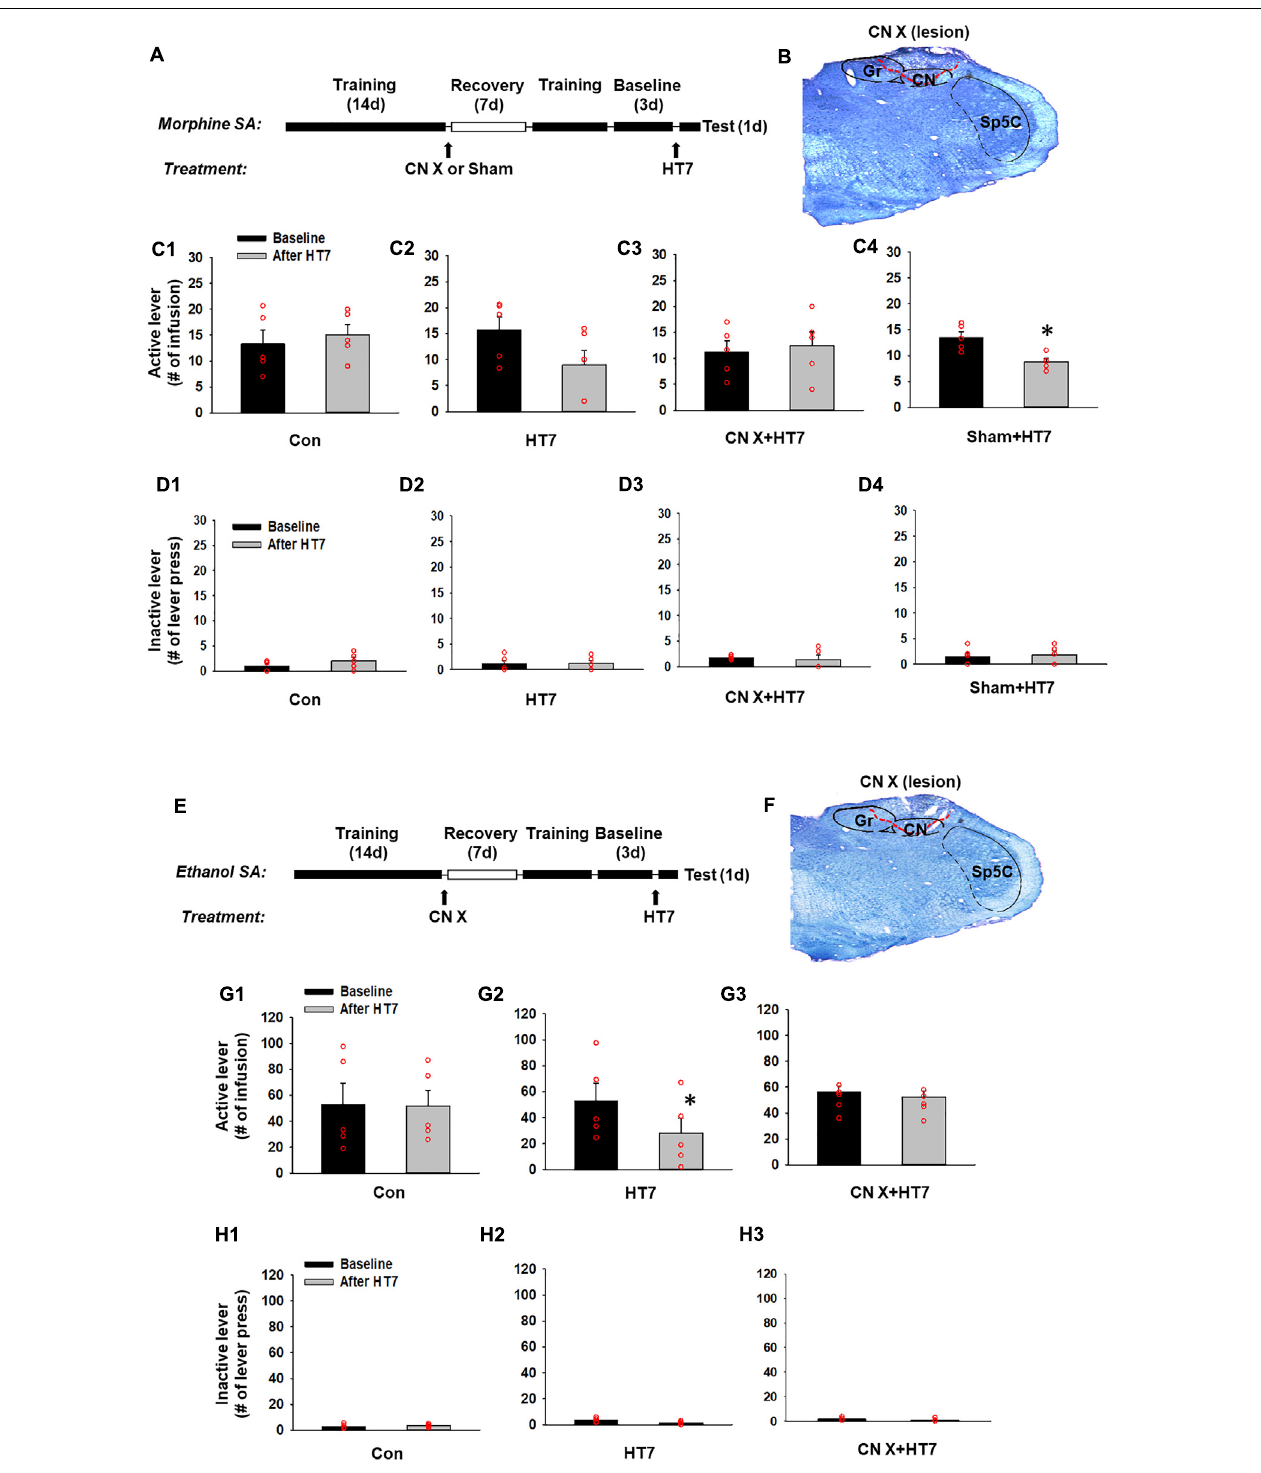
FIGURE 2 | Effect of cuneate nucleus (CN) lesions on the inhibition of morphine or ethanol self-administration behaviors by acupuncture at HT7. (A–D) The effect of CN lesions on the inhibition of morphine self-administration behaviors by acupuncture at HT7. A schematic of the procedure of the morphine self-administration experiment (A) . While sham operation without HT7 acupuncture did not affect the number of active lever presses (Con) (C1) , the active lever response in the HT7-treated group was significantly reduced after HT7 stimulation compared to baseline (HT7; paired t -test, ∗ p = 0.008 vs. Baseline) (C2) . These acupuncture effects were ablated in the rats with CN injury (CN X+HT7) (C3) . HT7 acupuncture significantly reduced morphine intake in sham group, compared to baseline